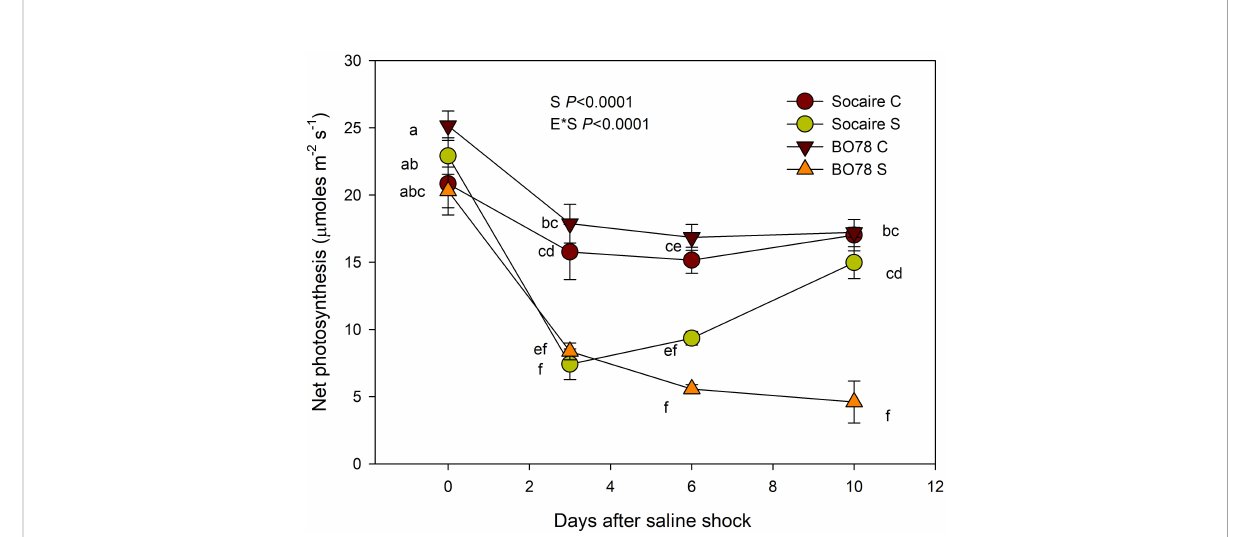
FIGURE 2 Salinity effect on net photosynthesis (Pn) of Socaire and BO78 ecotypes of quinoa. Plants grown under control conditions (C, 0 mM NaCl) were exposed to salinity shock (S, 400 mM NaCl) and recovered by 10 days. Error bars show mean ± SE (n = 12). Different letters indicate signi fi cant differences between ecotypes (E) and salinity treatments (T) using repeated measures ANOVA ( p <